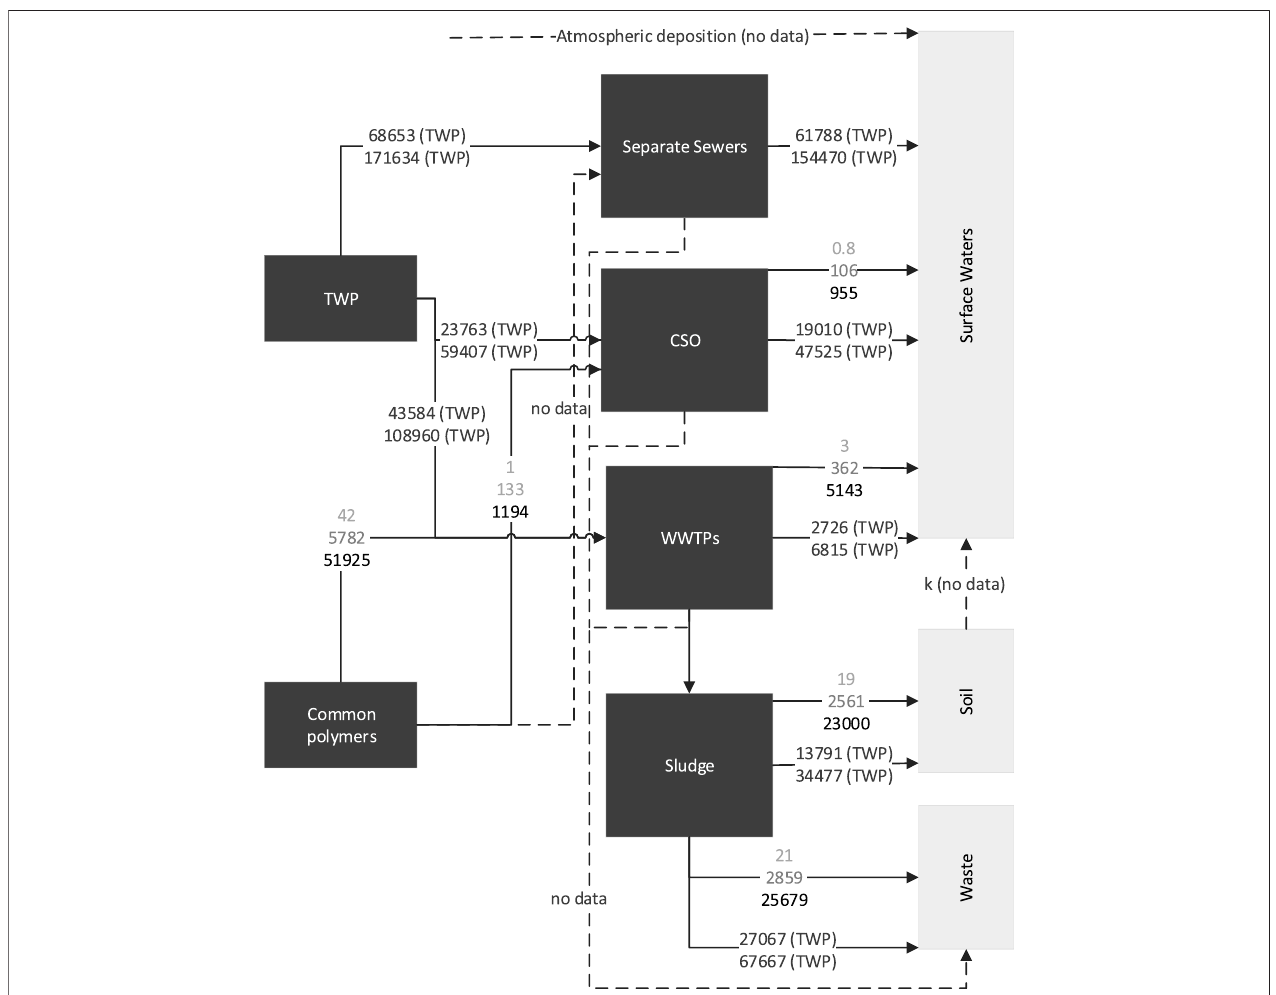
FIGURE 1 | Preliminary mass balancesof common MP (with scenariosof low, medium, and high estimates in different grey scales) and TWP in Europe (scenario 1 (upper number) and scenario 2 (lower number)) (all numbers are Mg/a). Dashed lines represent unquanti fi ed fl ows.